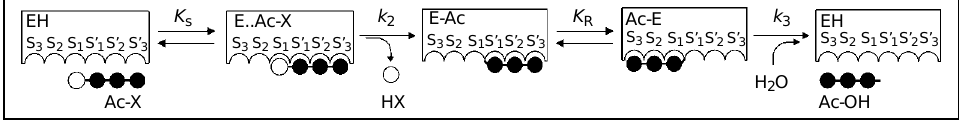
Figure 5 - Partition values p for the aminolysis of Boc- D / L -Ala- OGp and Boc- D / L -Leu-OGp com- pared to the common substrate Bz-Arg-OEt by trypsin (25). Con- ditions: 0.2 M HEPES-buffer, pH 8.0, 0.2 M NaCl, 20 mM CaCl 2 , 25 o C; [substrate]: 2 mM, [amino component]: 20 mM; errors are less than 15%.